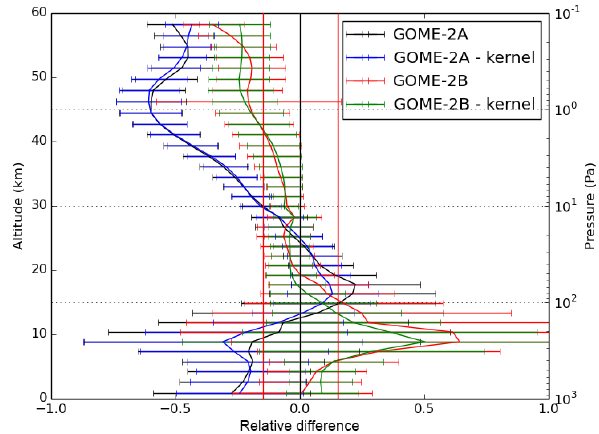
Figure 4. Relative differences between GOME-2A and GOME-2B ozone profiles (CR) and corresponding ozone sonde, lidar and mi- crowave measurements. Shown is an average over all data from the years 2013 and 2014 for northern midlatitude stations. Up to 30km altitude, all available ozone sondes are used for compari- son, and above it is an average of two lidar (Hohenpeissenberg and Haute Provence) and two microwave stations (Bern and Payerne). The black (GOME-2A) and red (GOME-2B) curves are raw data, while the blue (GOME-2A) and green (GOME-2B) curves show data smoothed with the GOME-2 averaging kernel and a priori in- formation. The red vertical lines mark the ± sigma range of devia- tions.